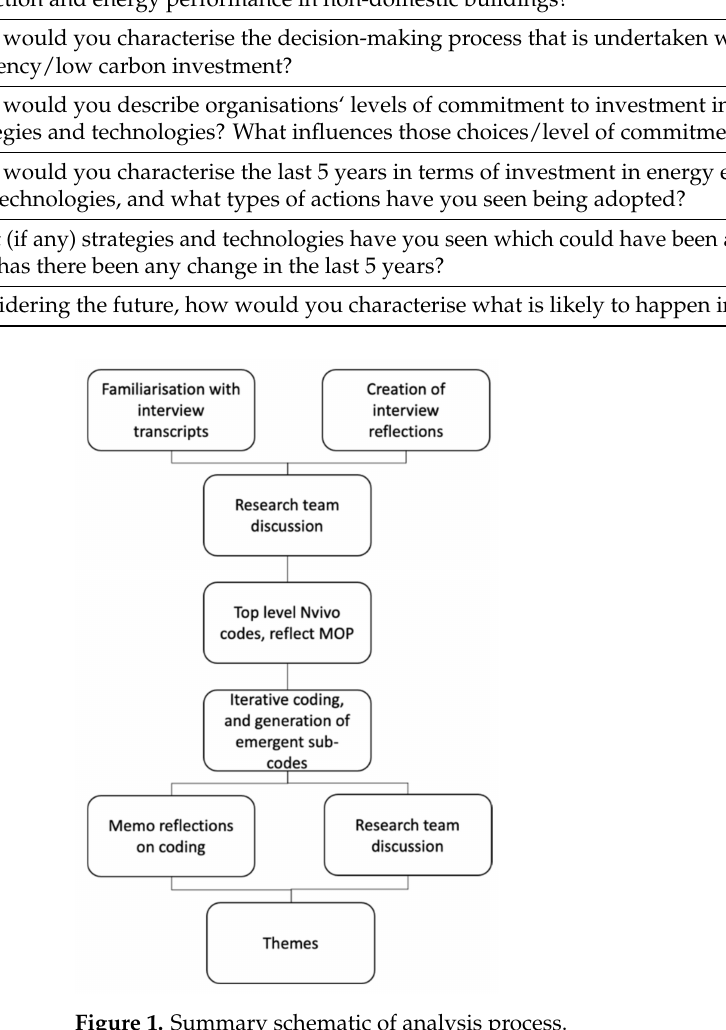
Figure 1. Summary schematic of analysis